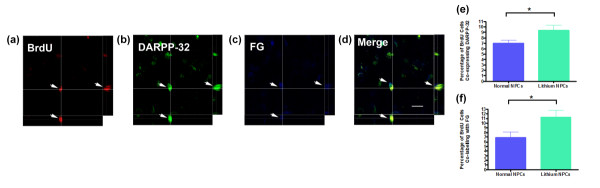
In vitro priming of SVZ-derived adult neural progenitor cells with lithium chloride enhances the formation of region-specific mature neurons 12 weeks after transplantation. (a through d) Representative confocal micrographs with orthogonal projections of BrdU-labeled lithium chloride-primed adult neural progenitor cells co-expressing DARPP-32, a marker of striatal medium-size spiny projection neurons retrogradely co-labeled with Fluorogold (FG) from the globus pallidus. Graphs comparing the proportion of transplanted BrdU-labeled cells co-expressing (e) DARPP-32, or (f) FG labeling 12 weeks after transplantation. Scale bar = 20 μm. *P < 0.05.